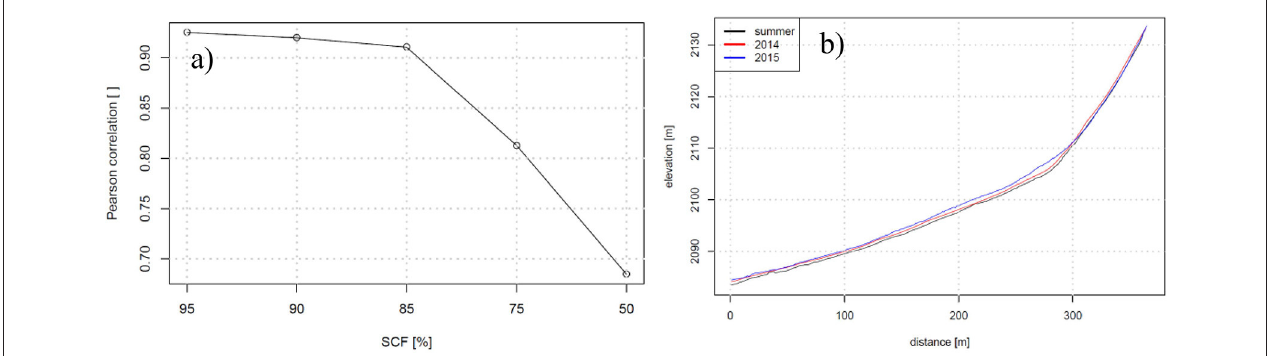
FIGURE A2 | Comparison of the Alpine snow cover at Gletschboden in 2014 and 2015: Pearson correlation coefficient of the snow height of both years as a function the snow cover fraction (a) . Cross section of digital elevation model for summer and the time of peak accumulation 2014 and 2015 (b) .